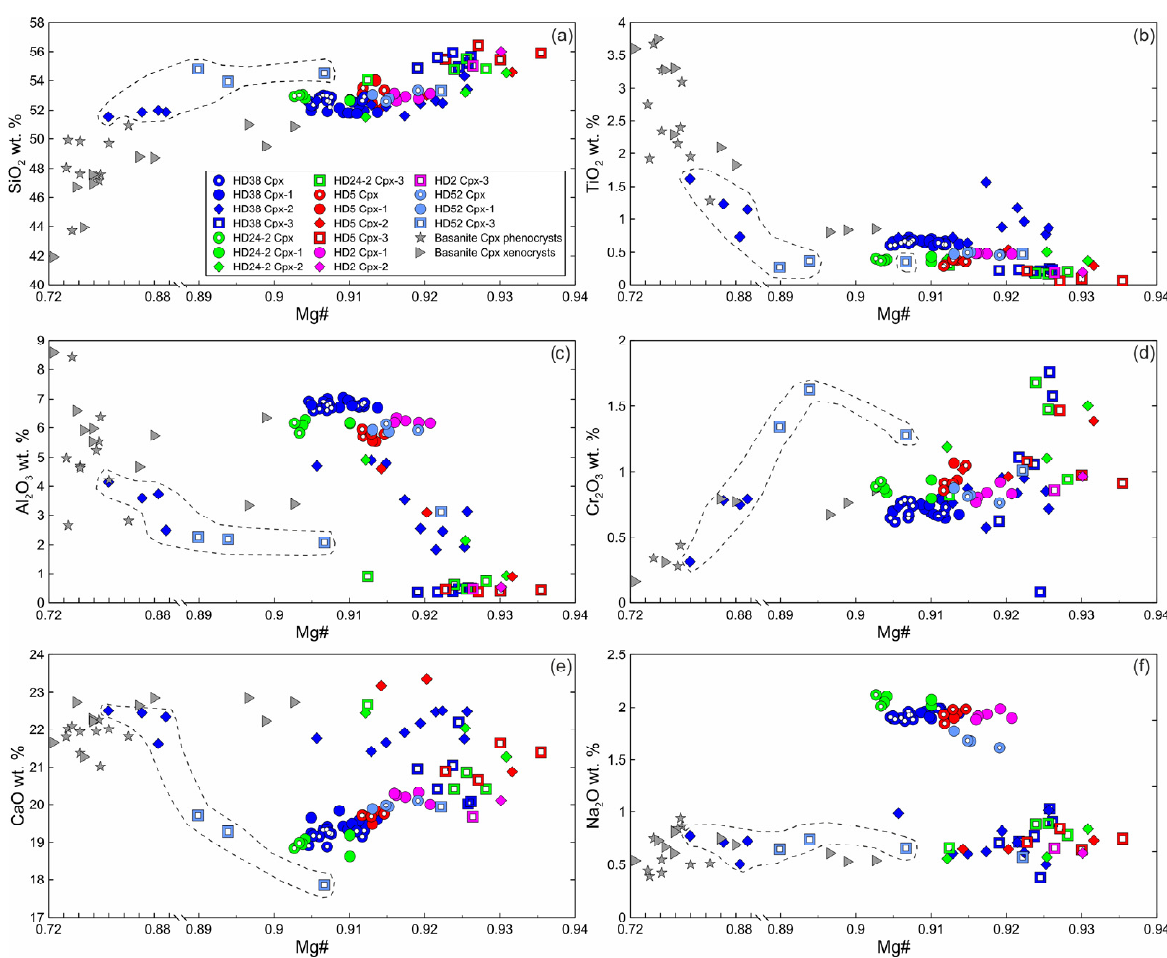
Figure 5. Composition of clinopyroxene from Tumusun lherzolite xenoliths. ( a ) SiO 2 ‐ Mg#, ( b ) TiO 2 ‐ Mg#, ( c ) Al 2 O 3 ‐ Mg#, ( d ) Cr 2 O 3 ‐ Mg#, ( e ) CaO ‐ Mg#, ( f ) Na 2 O ‐ Mg#. Cpx—primary Cpx without reaction zones, Cpx1—core of clinopyroxene with reaction zones, Cpx2—secondary clinopyroxene from the reaction zone of Cpx1, Cpx3—secondary clinopyroxene from the reaction zone of Opx1. The dashed line shows compositions of secondary clinopyroxenes at basanite/xenolith contact.